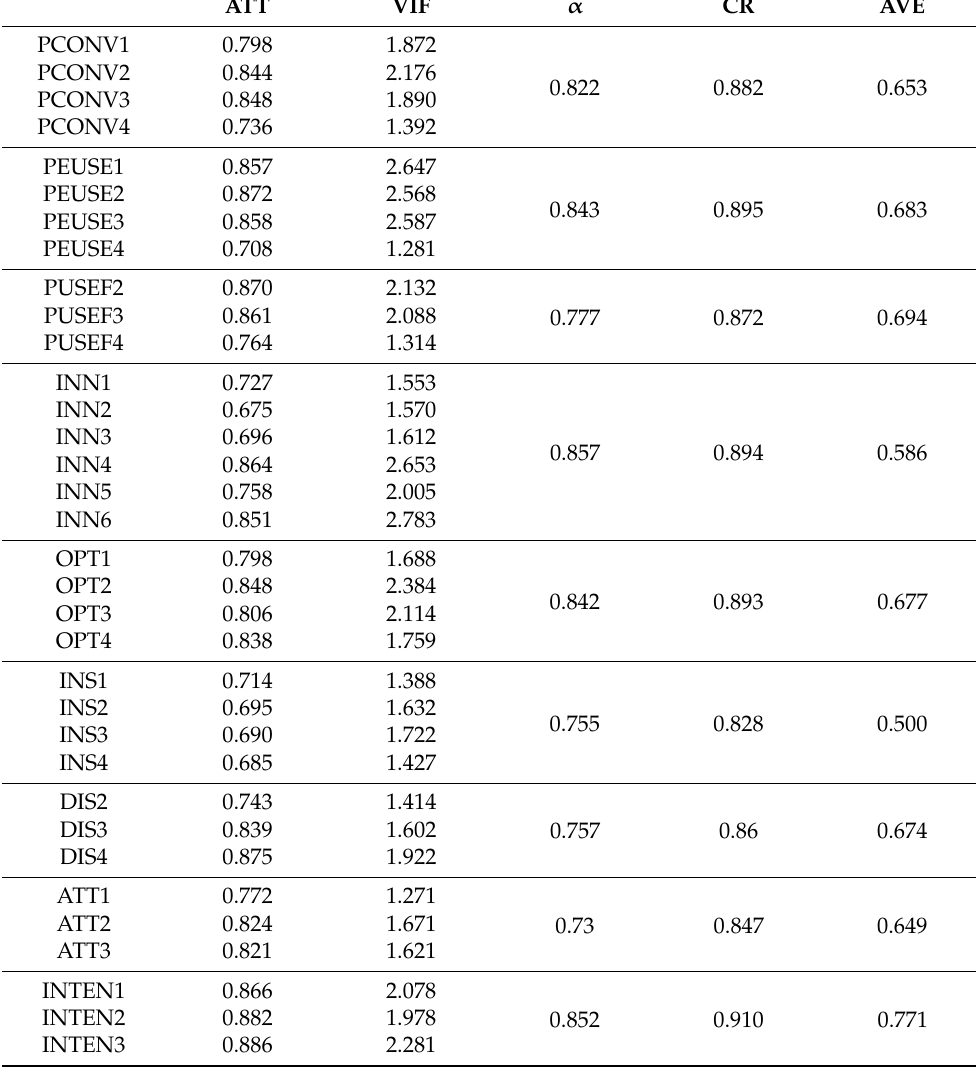
Table 3. Reliability and Validity of Constructs.